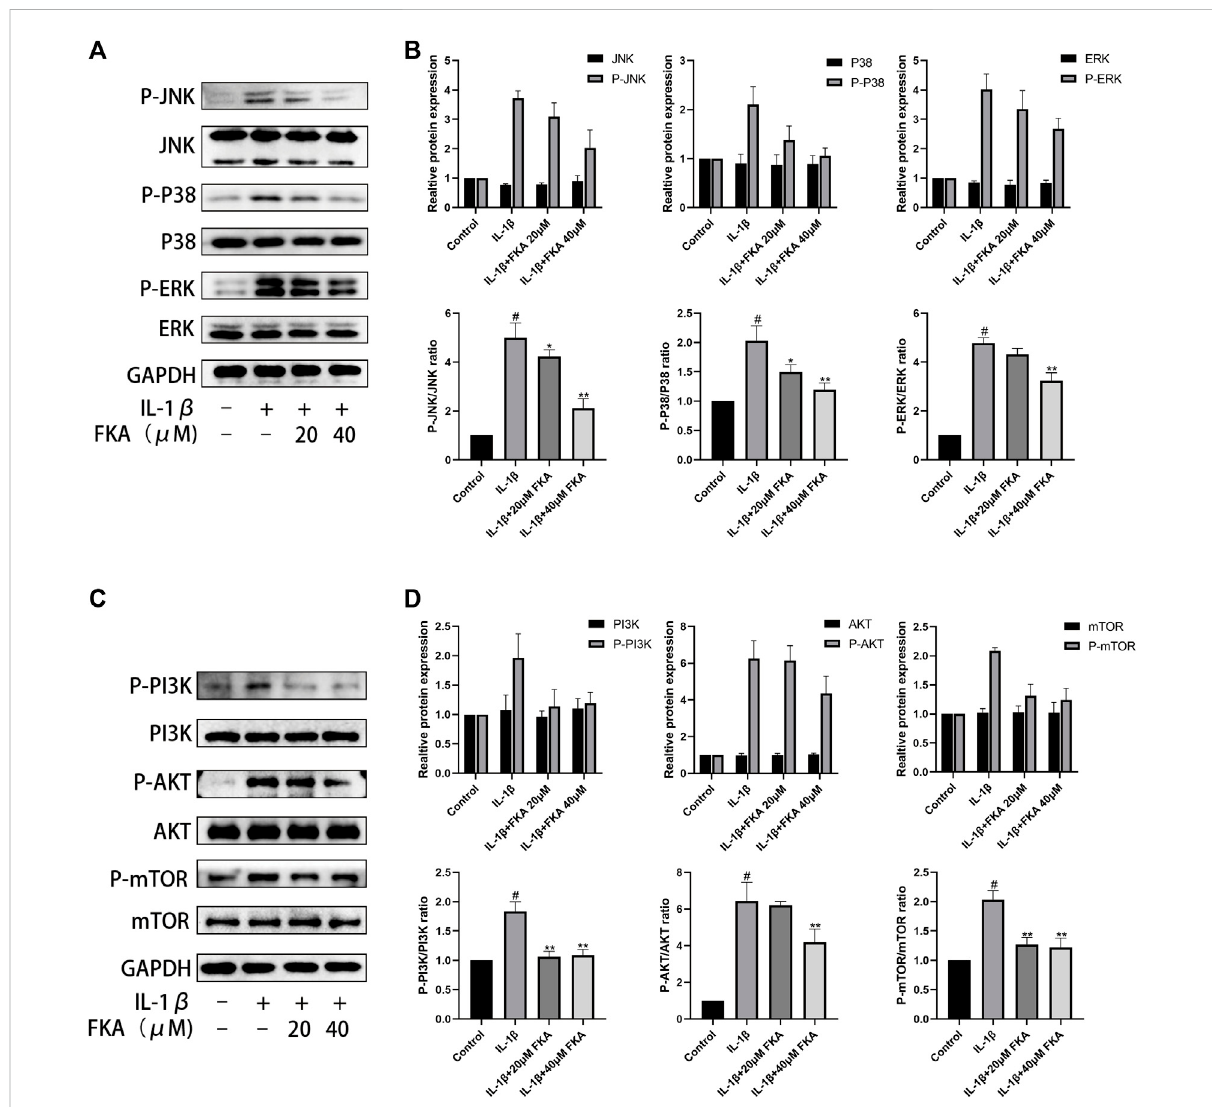
FIGURE 8 EffectofFKAonthePI3K/Akt/mTORpathwayandMAPKpathwayinducedbyIL-1 β inmousechondrocytecells (A) Theexpressionofproteinsof theMAPKpathway illustratedbywesternblotanalysis. (B) Quantitativeanalysisofproteinexpression. (C) Westernblotresultsshowtheexpressionof proteinsofthePI3K/Akt/mTORpathway. (D) Quantitativeanalysisofproteinexpression.Thevaluesarepresentedasmeans±SD( n =3).# p <